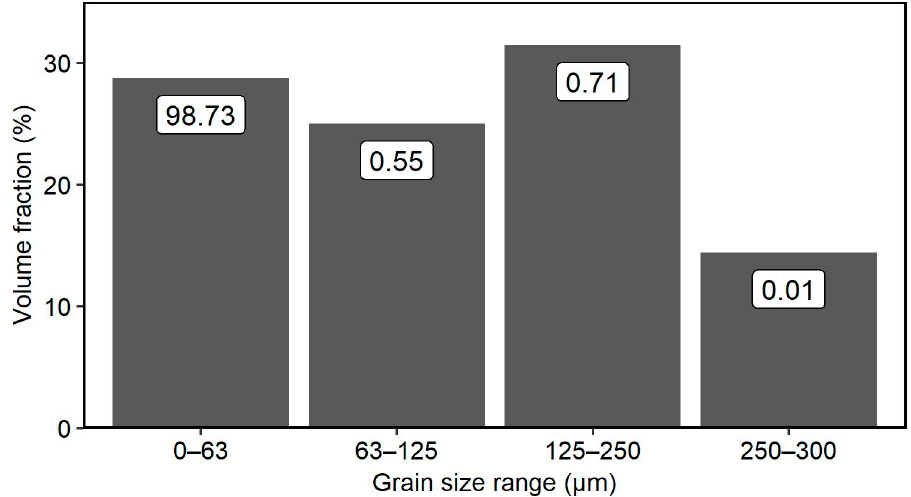
Figure 2. Particle size distribution of fine fraction GFH ( µ GFH) by volume estimated from particle sizes determined using a particle analyzer; numbers indicate detected particle numbers (in % of the total number) of the fraction.